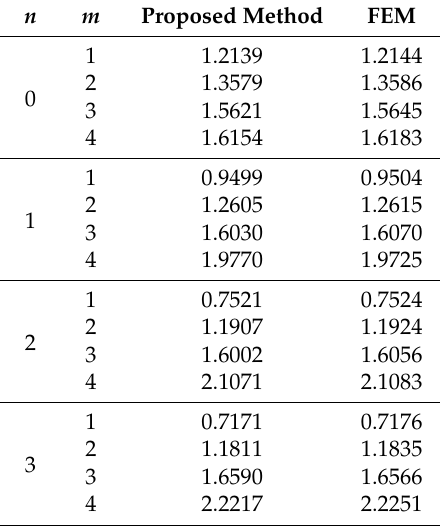
Table 3. Comparison of frequency parameter Ω for stepped doubly curved paraboloidal shell (FGM I ( a , b , c , p =